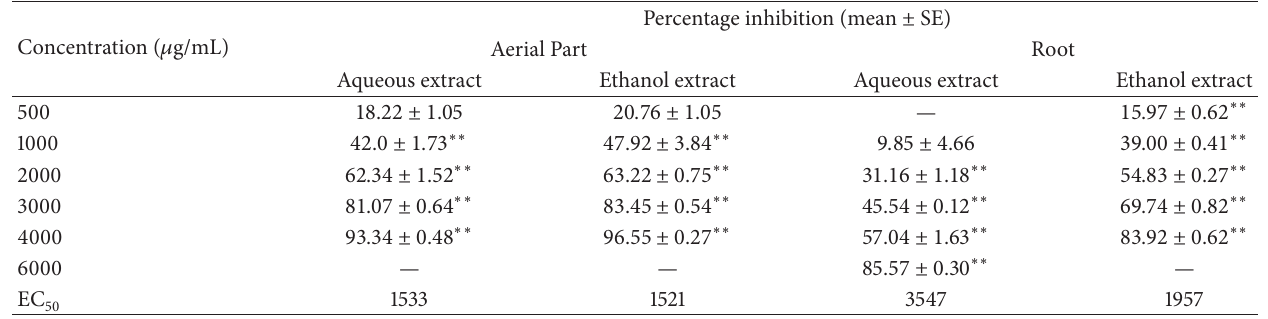
Table 3: Lipid peroxidation activity of P. fraternus aqueous and ethanolic extracts of aerial part and root. Concentration ( 𝜇 g/mL)